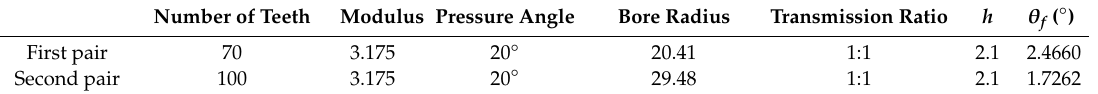
Table 7. Parameters of two standard involute spur gear pairs.